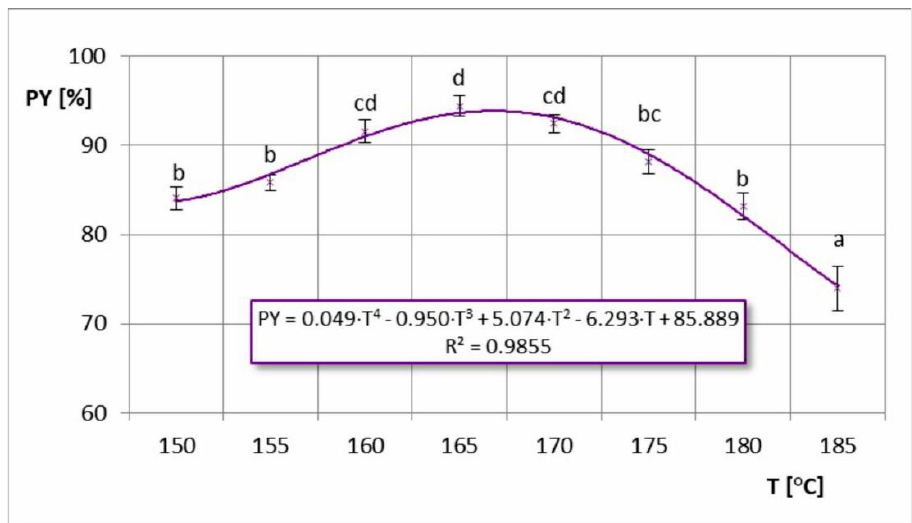
Figure 3. Powder yield ( PY) in the process of spray drying chokeberry juice at different inlet air temperatures (T); (a, b, c, d — different letters show significant differences between mean values ( p ≤ 0.05)).